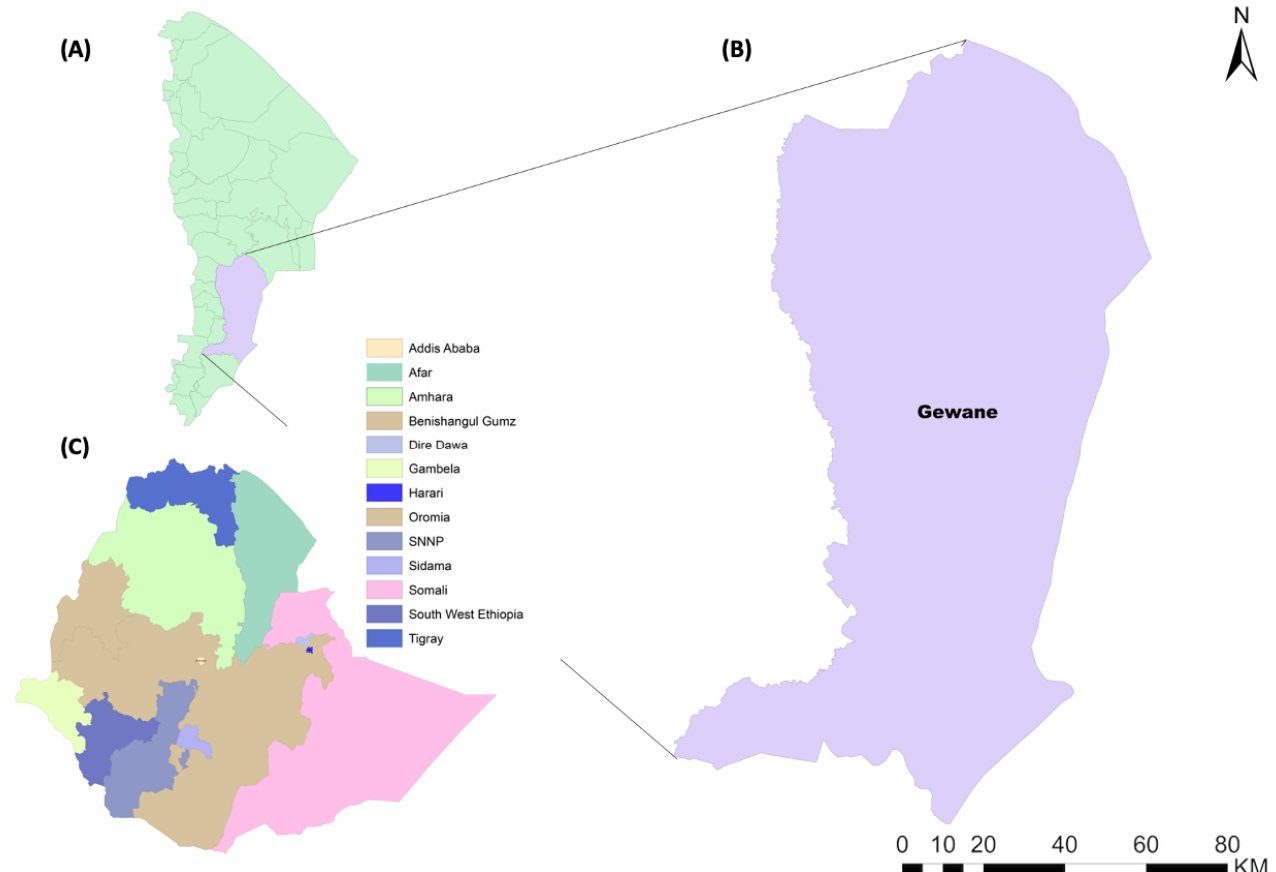
Figure 1. Map of Afar Region ( A ) and the study area, Gewane District ( B ), relative to all Regional States in Ethiopia ( C ).